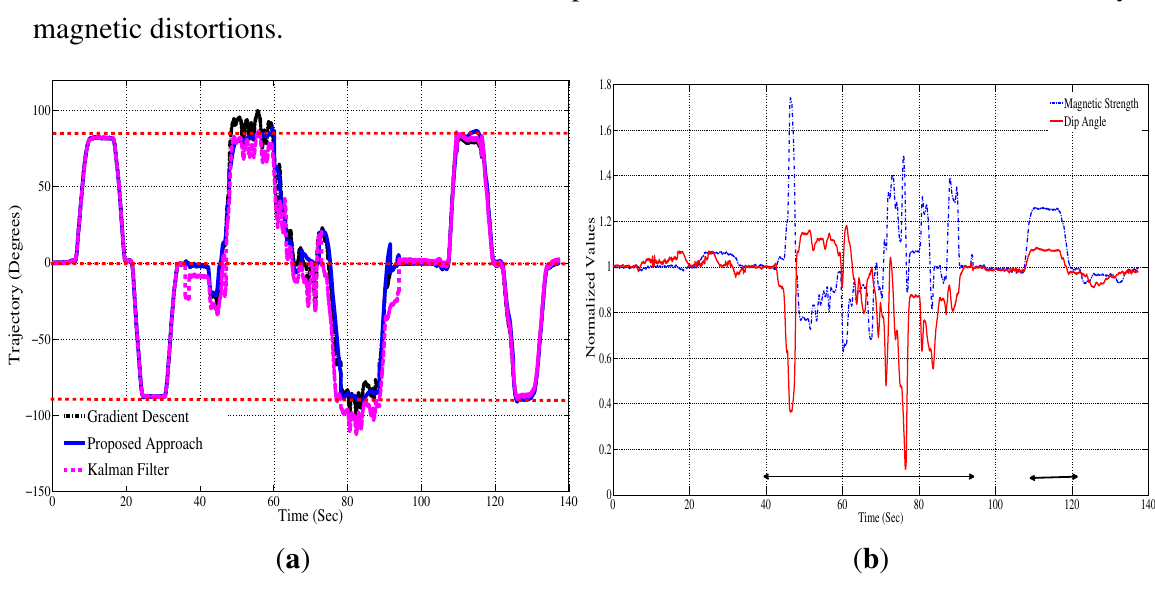
( a ) Trajectory estimation during movement of ± 90 ◦ along three axes; ( b ) normalized magnetic strength values and magnetic dip angles used for distortion detection.